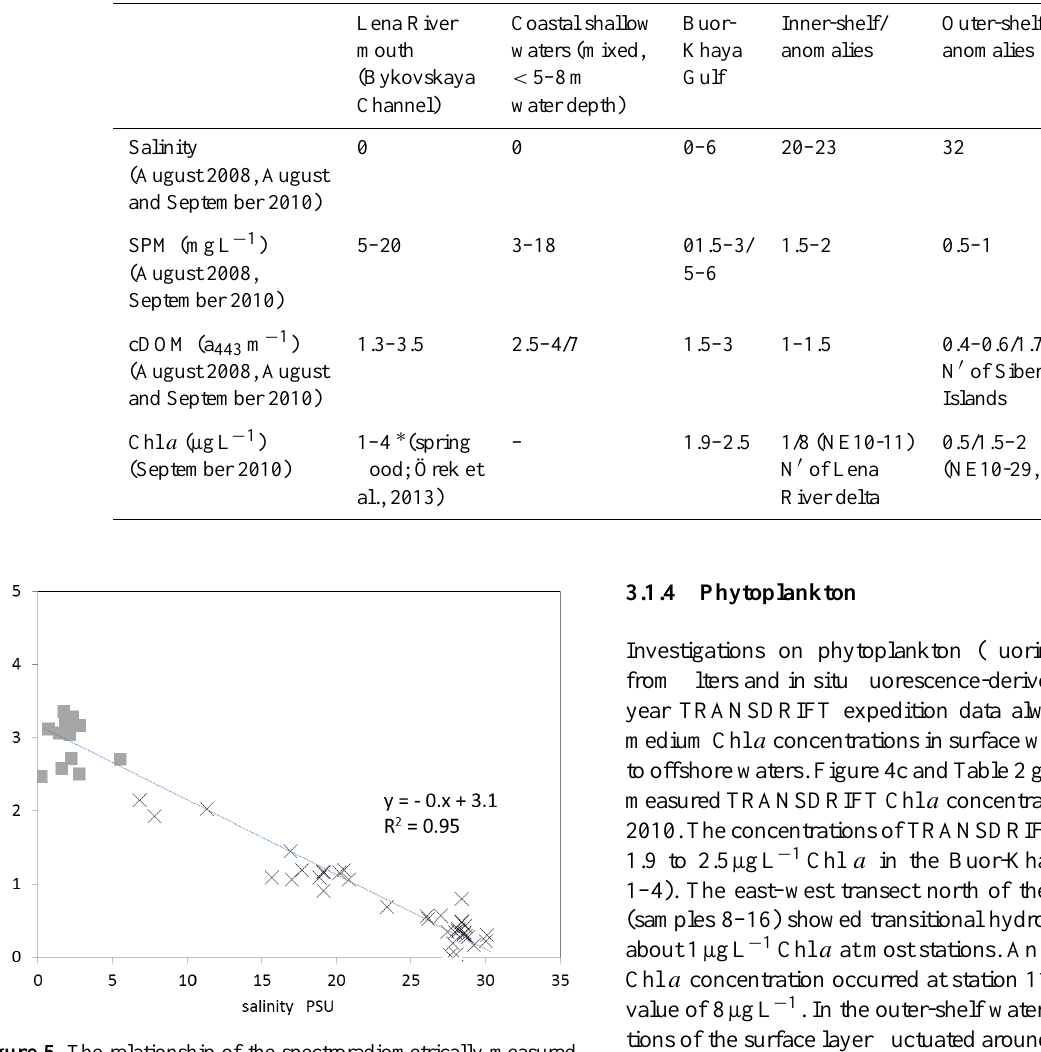
Figure 5. The relationship of the spectroradiometrically measured cDOM (absorption at 443 nm, m − 1 ) vs. salinity on the L10 (squares) and TRANSDRIFT XVII (crosses) ship expeditions in 2010 shows the quasi-conservative mixing behaviour of cDOM over a wide range of salinities from the inner- to the outer-shelf surface